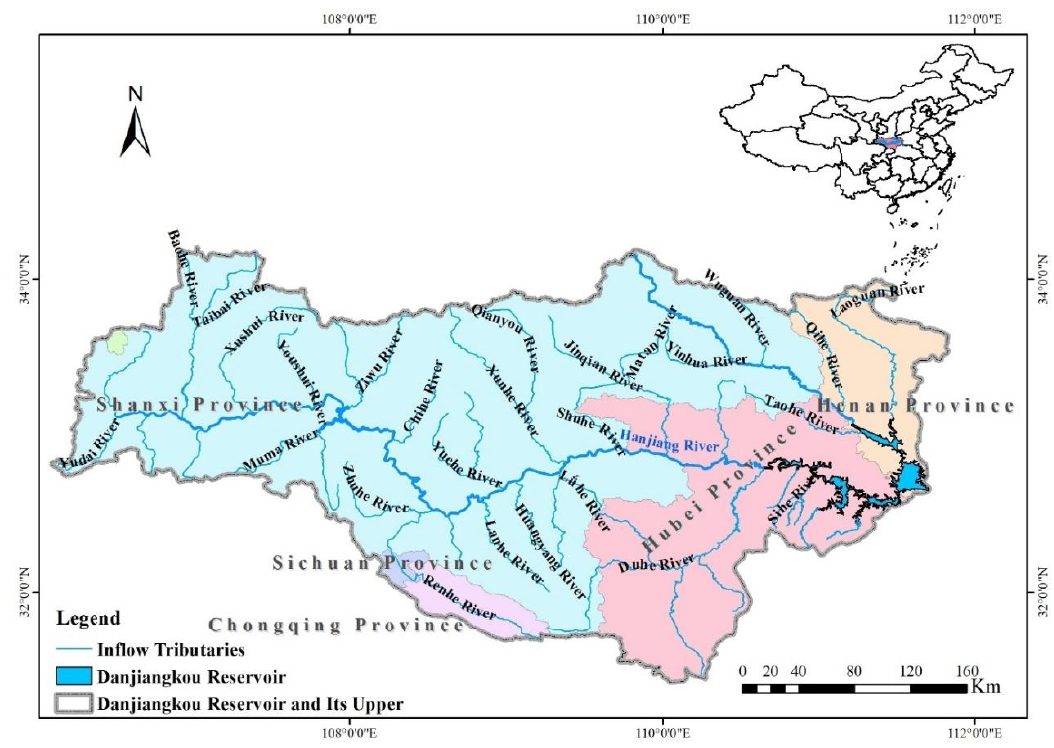
Figure 2. River system in the Danjiangkou Reservoir watershed. Table 2. Characteristics of the main inflow tributaries of the Danjiangkou Reservoir